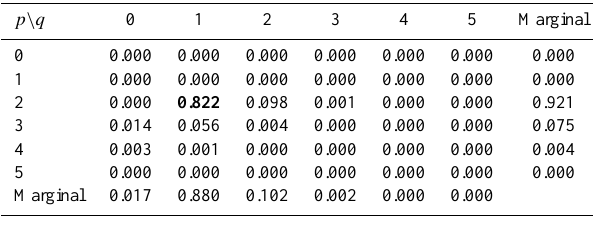
Table 2. Posterior model probabilities for time series from Figs. 6a, b and 8a, b for the autoregressive parameter p and moving average parameter q . Bold numbers denote the true model.